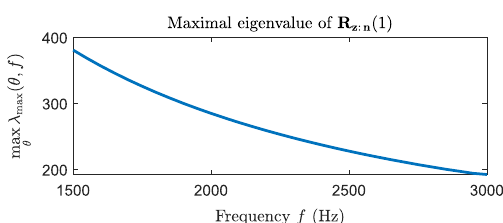
(cid:31) max (θ , f ) , where θ is the angle between the horizontal steering direction and the array